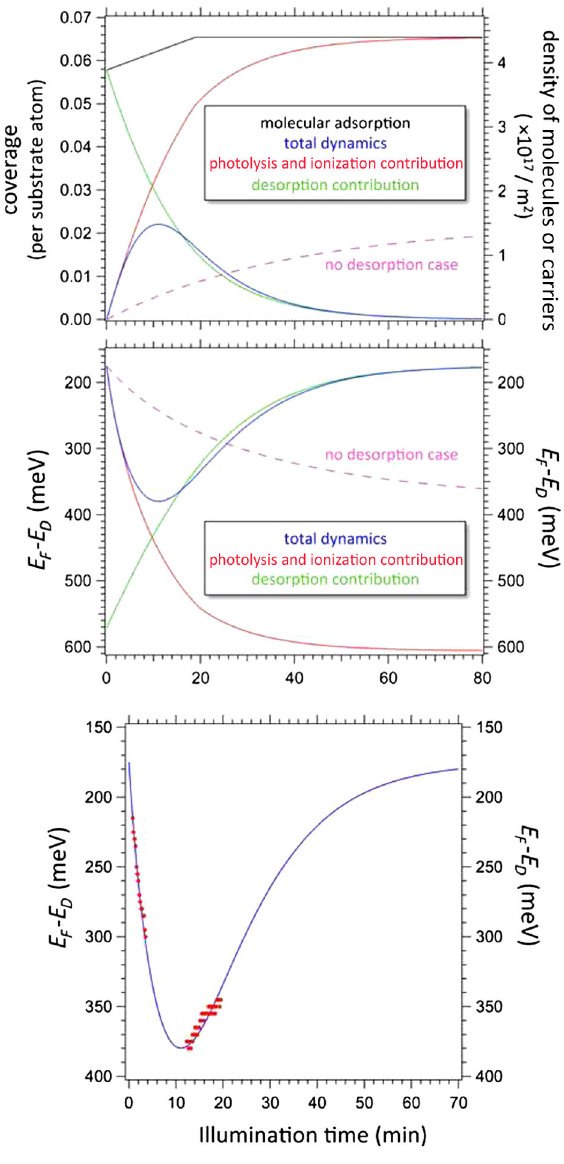
FIG. 6. A quantitative model of the microscopic procedures behind the surface band bending in 3D TIs. Top: Time-dependent coverage or density of adsorbed molecules and created charges. Black, red, and green curves follow the coverage or density of, respectively, adsorbedmolecules,charges createdbyphotoinduced processes, and molecules desorbed due to incoming photons. Center: Corresponding time-dependent energy value of the Fermi level with respect to the Dirac point. Red and green curves follow the energy variation due to photoinduced processes of charge creation and molecular desorption, respectively. In both the top and center panels, the blue curve shows the total dynamics under the assumption that photostimulated desorption at a local site occurs only after the “ activation ” of the specific molecule. The dashed curve describes the total dynamics if in the absence of photo- stimulated desorption the maximum value of surface band bending were to stay unaltered. Bottom: Time-dependent energy variation of the Fermi level in comparison with the experimental data of Fig. 4 showing that the down-shift and up-shift rates are well reproduced. Details on the model parameters are given in the